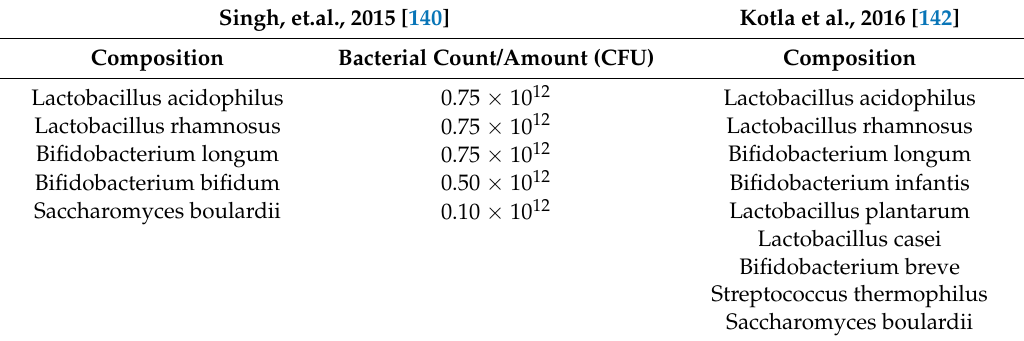
Table 4. Species selected for the bacterial mixture, as well as the amounts of different bacteria used to create a dissolution media simulating the colon by Singh et al. [144] and Kotla et al.